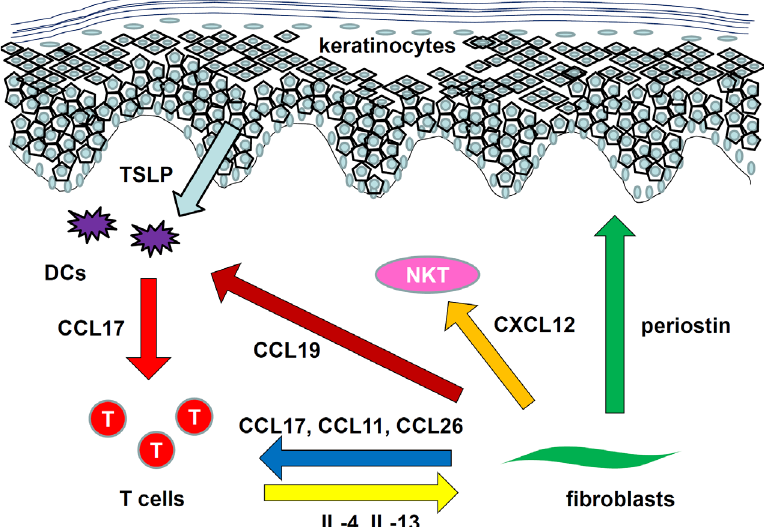
Figure 4. Role of fibroblasts in AD. Fibroblasts express CCL17, CCL11. CCL26, CXCL12, CCL19, and periostin, interacting with T cells, NKT cells, DCs, and